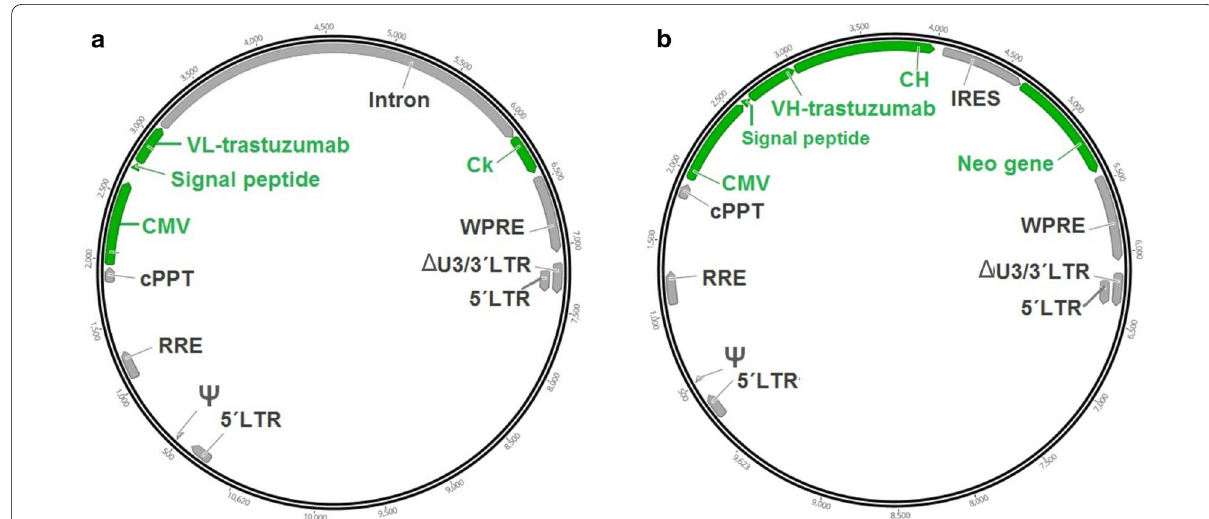
Fig. 1 Schematic diagram of the LV transfer plasmids used. a pLW‑CMV‑trastuzumab LC and b pLV‑CMV‑trastuzumab HC‑IRES‑Neo, encoding light chain (LC) and heavy chain (HC) of trastuzumab, respectively. 5´LTR: HIV‑1 truncated 5 ′ long terminal repeat. Ψ: HIV‑1 psi packaging signal. RRE Rev response element, cPPT central polypurine tract, CMV human cytomegalovirus promoter, VL variable region of LC, Ck constant region of LC (kappa), VH variable region of HC, CH constant region of HC, IRES internal ribosome entry site, Neo gene neomycin phosphotransferase gene, WPRE woodchuck hepatitis virus posttranscriptional regulatory element. ΔU3/3´LTR: HIV‑1 truncated 3 ′ long terminal